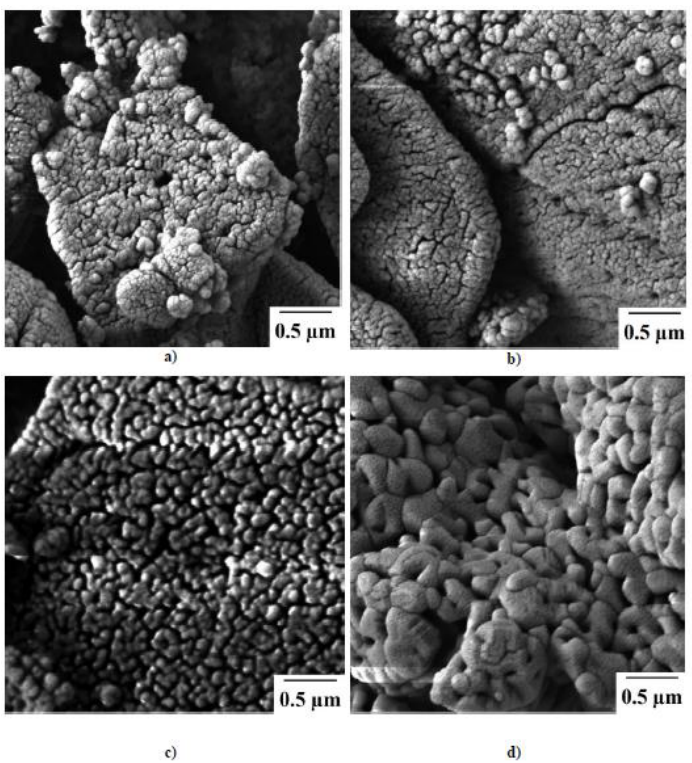
Figure 3. SEM images of Sm 2 O 2 S ( a ) and of Sm 2 O 2 SO 4 samples obtained at temperatures of 600 °C ( b ), 800 °C ( c ) and 1000 °C ( d ).